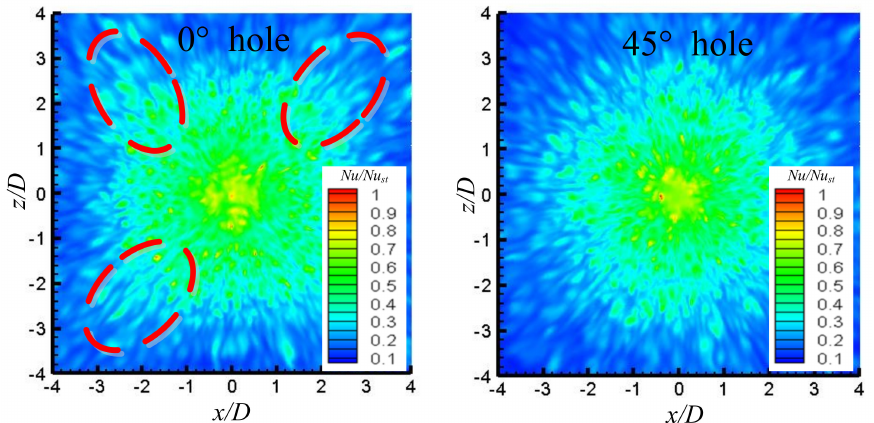
Figure 15. Cloud plot of the distribution of instantaneous Nu number ratio on the target